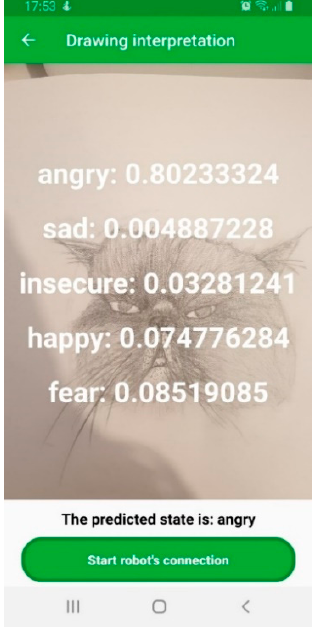
Figure 7. PandaSays drawing prediction screen.